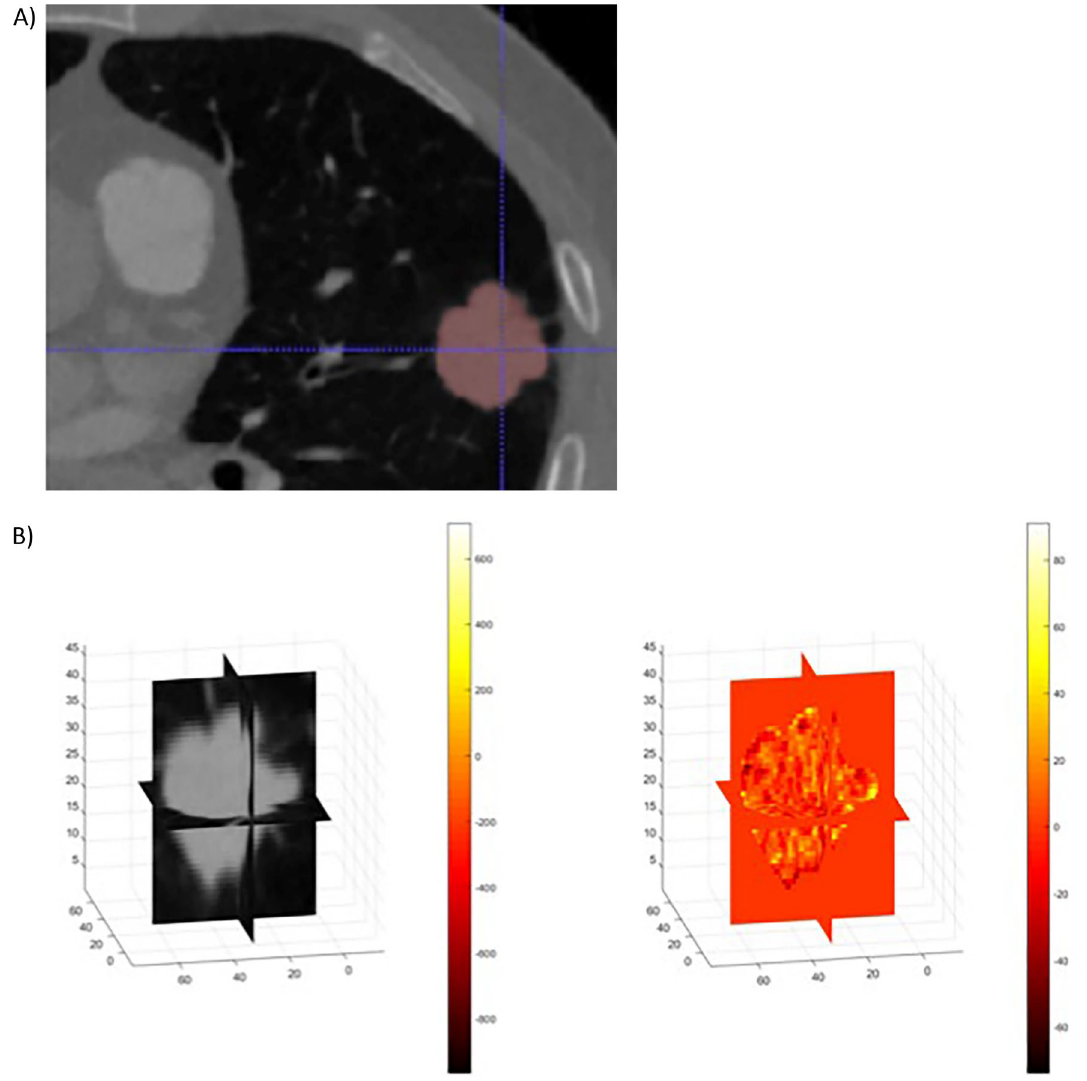
Figure 2. Volumetric lesion segmentation. ( A ) Axial image demonstrating lesion segmentation mask on low-kV dataset using ITK-SNAP (http:// www. itksn ap. org/ pmwiki/ pmwiki. php). ( B ) Lesion result volume reflecting iodine density (mg/mL) using R2018B Matlab